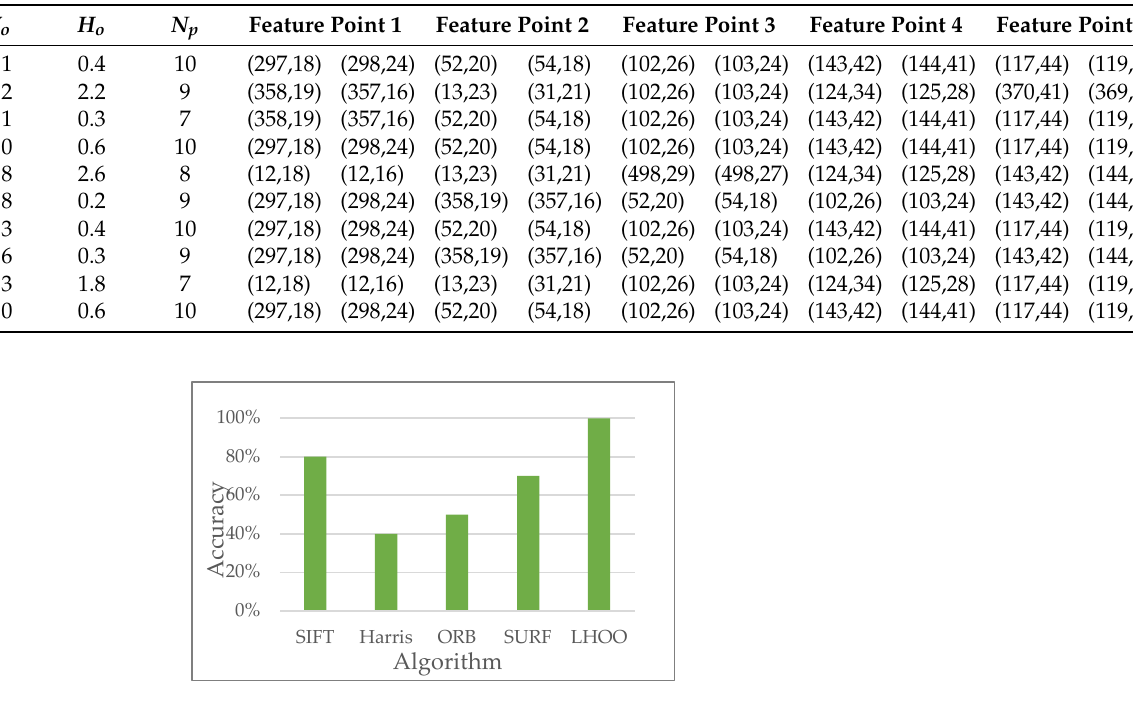
Figure 7. Matching accuracy of different algorithms.